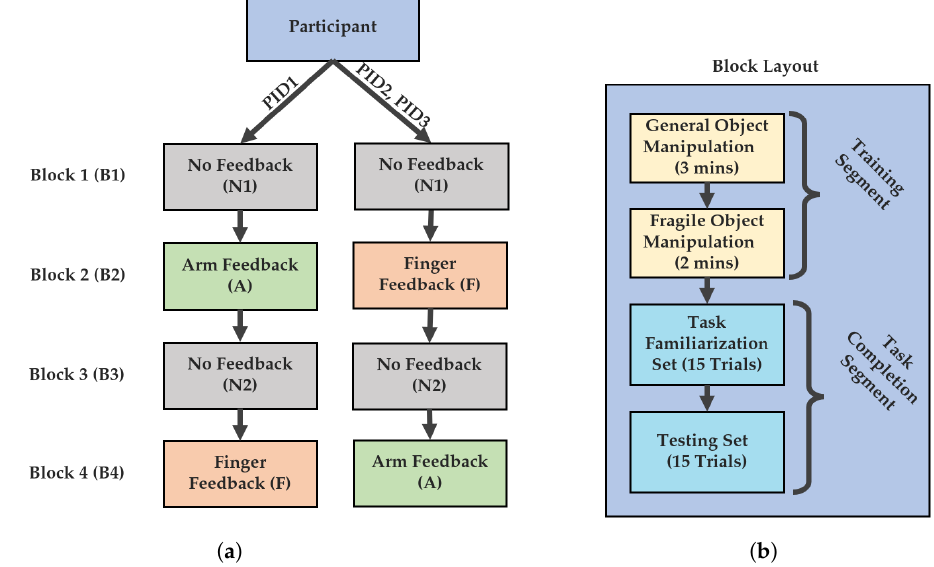
Figure 8. Experimental protocol. ( a ) Block presentation order summary. ( b ) Block layout